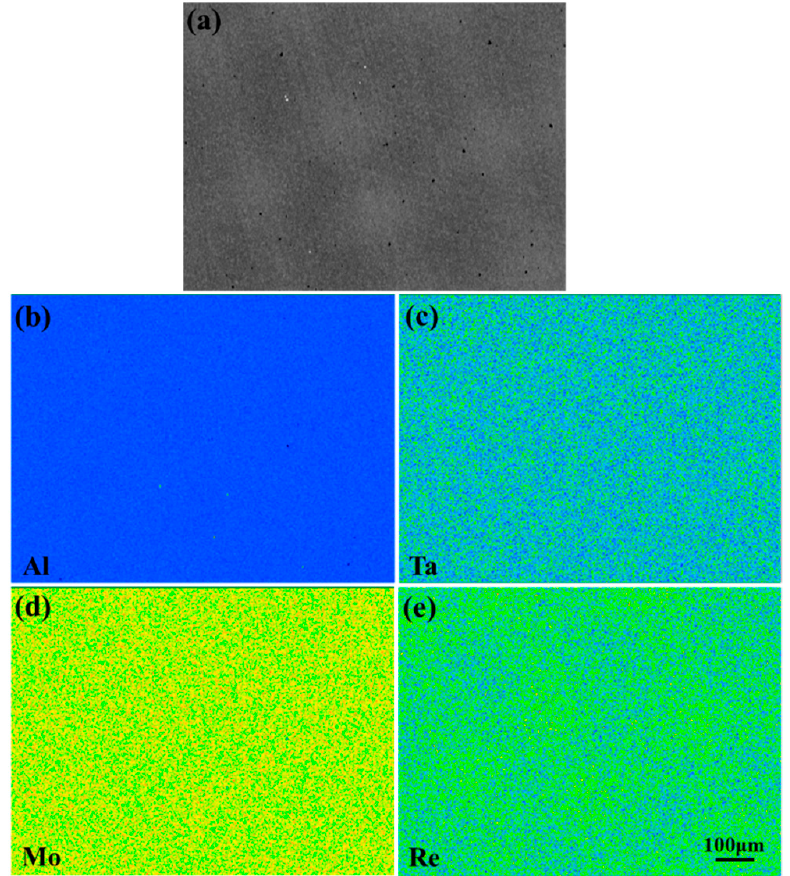
Figure 2. ( a ) The SEM-BSE morphology of alloy after ST treatment and elemental distribution map: ( b ) Al, ( c ) Ta, ( d ) Mo and ( e ) Re. The microstructure of γ (cid:48) phases under different cooling conditions are shown in Figure 5. It is found that the finer γ (cid:48) phases are distributed orderly under WQ cooling condition, and the four sides are concave, as marked with a green dashed line in Figure 5a. This is due to the fact that the γ (cid:48) phase particles have the smallest elastic modulus along the [001] orientation; it will preferentially grow along the direction of body diagonals under the interaction of coherent strain. Meanwhile, the growth of cube corners will be enhanced due to the larger potential rate of supply of solute to these regions [30]. These γ (cid:48) phases are unstable, and as adjacent γ (cid:48) precipitates grow and collide with each other, the concave edges tend to be straightened due to the coherent strain energy [31]. In contrast, when